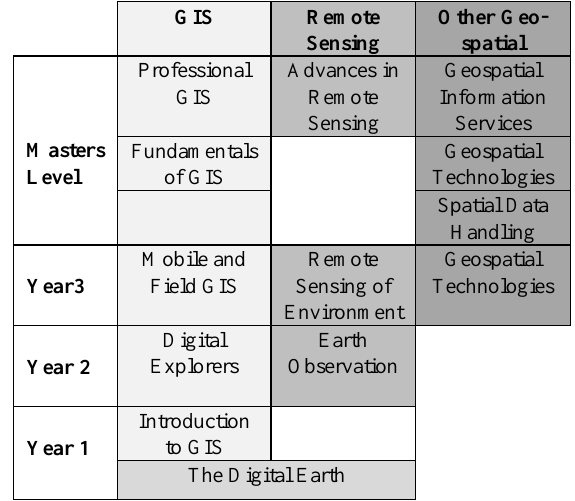
Table 1 GIS&T modules offered to Environmental